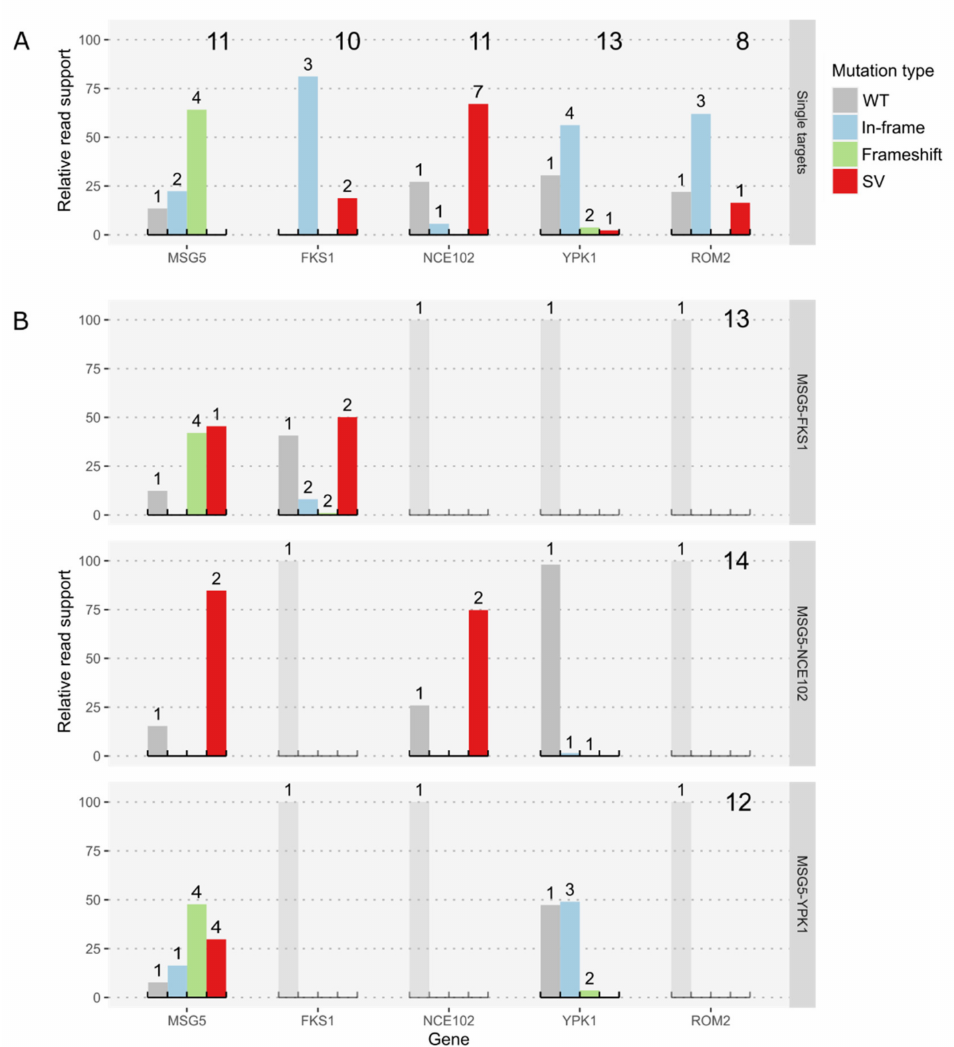
Figure 2. Comparison of on-target effects in single target ( A ) and double target experiments ( B ). Shown is the relative read support for the wildtype sequence and different groups of mutations. Large numbers on the right upper corners denote the number of sequenced colonies and the small numbers above bars denote the number of distinct genotypes per type of variant. Genotypes were classified into wildtype or no variant (WT), in-frame and frameshift InDels, including small Insertion and Deletions up to 50 bp, with a respective length of 3 nucleotides, or other length causing a shift